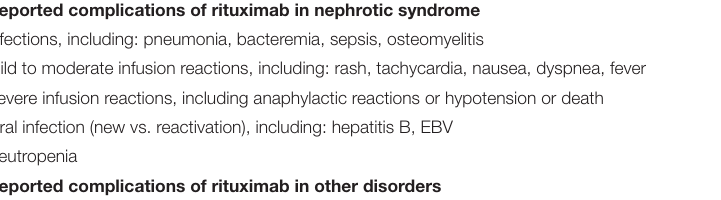
TABLE 1 | Complications reported with the use of Rituximab. Reported complications of rituximab in nephrotic syndrome Infections, including: pneumonia, bacteremia, sepsis, osteomyelitis Mild to moderate infusion reactions, including: rash, tachycardia, nausea, dyspnea,